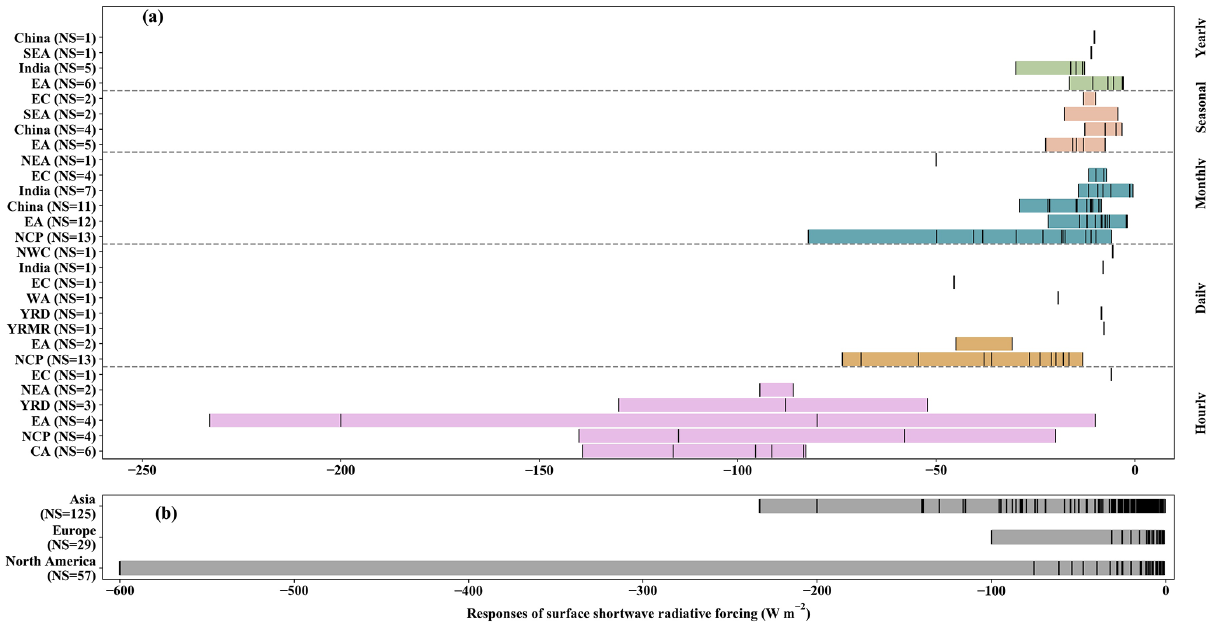
Figure 8. Responses of shortwave radiation forcing to aerosol feedbacks in different areas and periods in Asia (a) and the inter-regional comparisons of its variations in Asia, Europe, and North America (b)